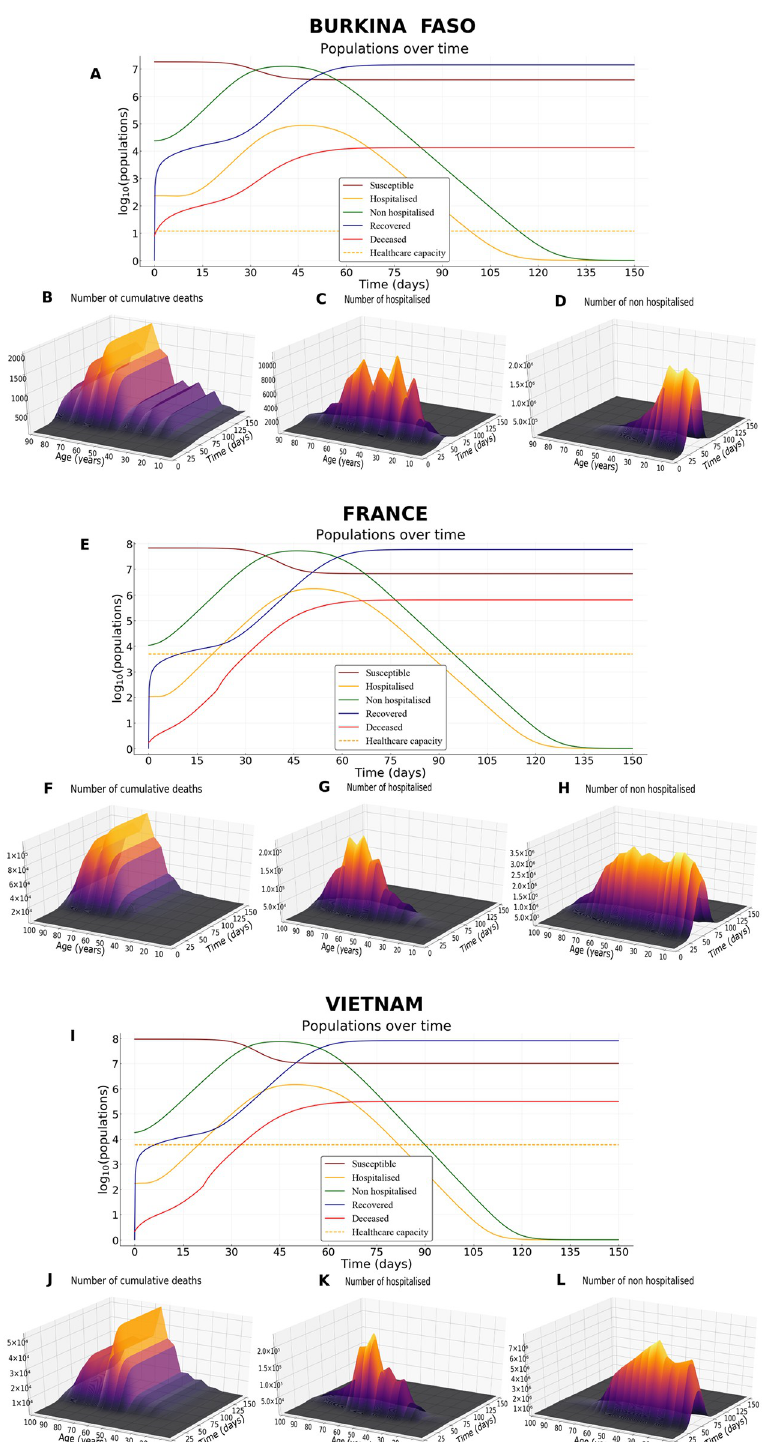
Fig 4. Epidemic scenario without any control measures. (A) Dynamics of epidemiological outputs, (B) number of cumulative deaths, (C) number of hospitalised and (D) non-hospitalised people in Burkina Faso. (E-H) As for (A-D) but in France. (I-L) As for (A-D) but in Vietnam. Parameter values are default in Table 1, R 0 = 3.3, and the proportion of paucisymptomatic infections is p = 0.5.